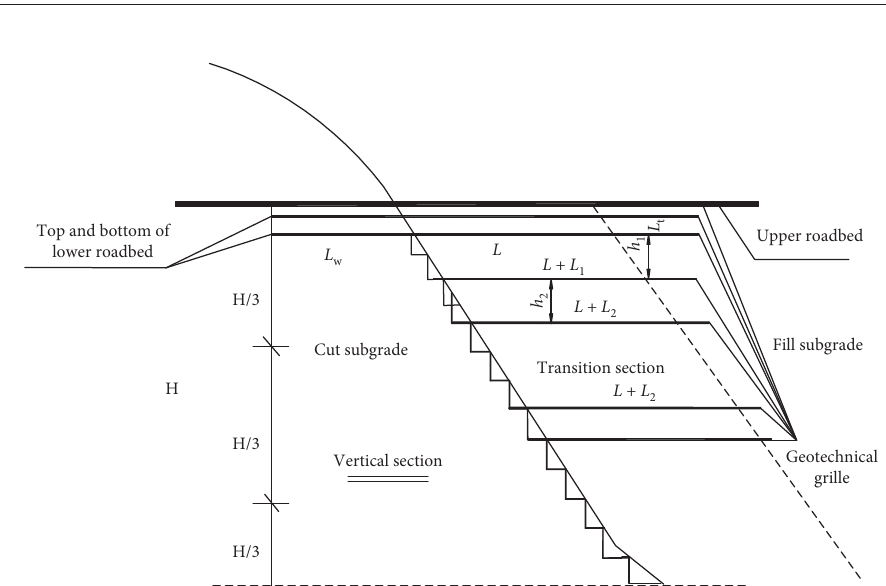
Figure 14: Schematic diagram of geogrid layout scheme for horizontal cut to fill